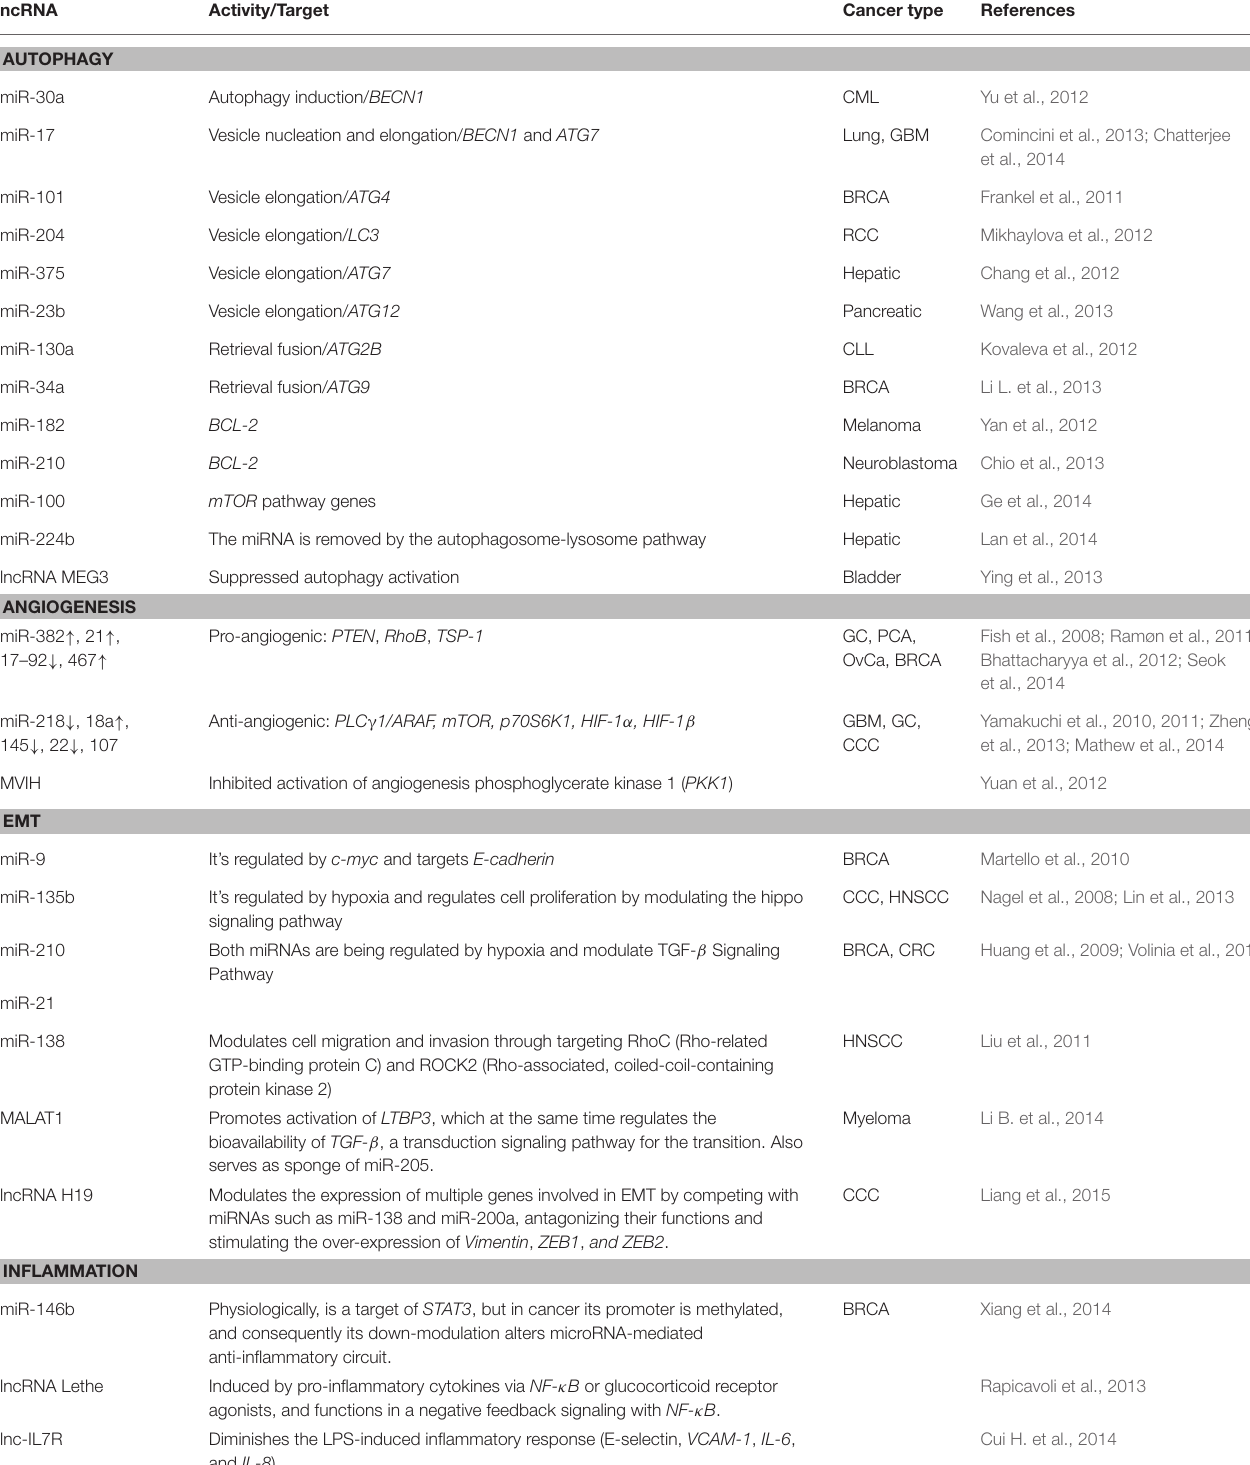
TABLE 4 | ncRNAs and their contribution to events in the metabolic changes in